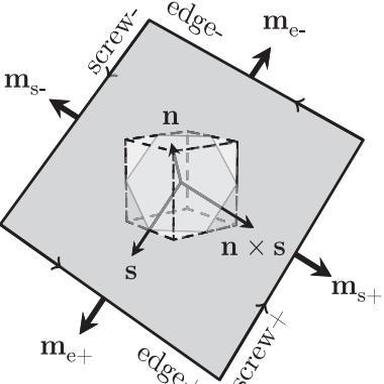
Schematic dislocation loop (dark shade) on its slip plane with normal n and slip direction s. Arrows along the loop periphery indicate positive line direction giving rise to the convention for signed dislocation characters as shown. The small (dashed line) interior cube illustrates the crystal unit cell orientation. A displacement step by b occurs when passing from below to above the shaded slip plane, i.e. along its normal n. Figure adopted from with permission from Elsevier.